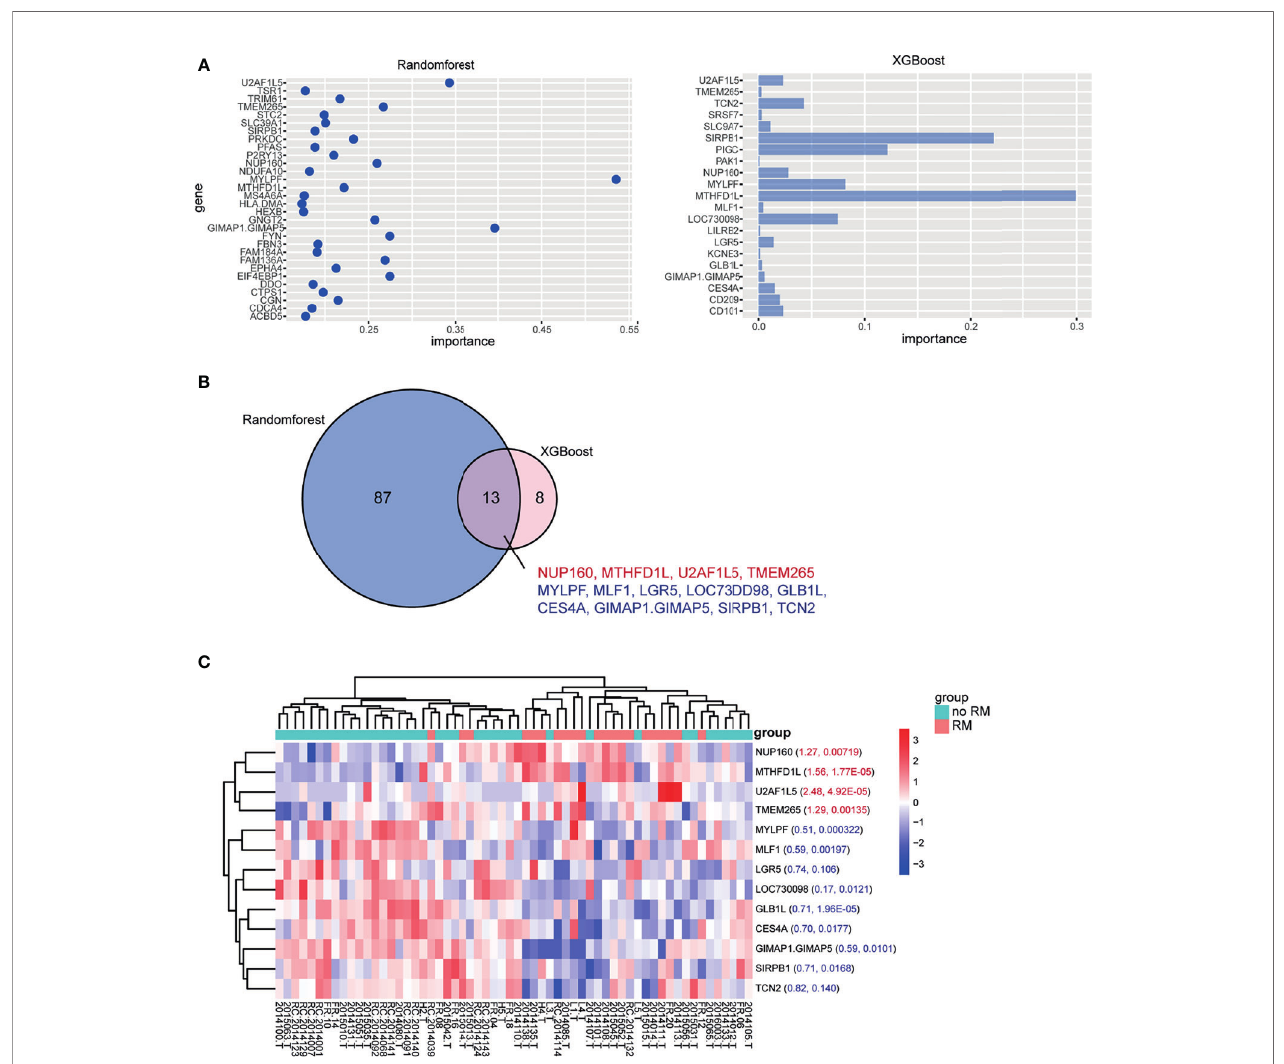
FIGURE 1 | Signi fi cant genes in the RM and no-RM groups. (A) mRNAs identi fi ed in the RM and no-RM groups classi fi ed based on the mRNA expression dataset with the RF method (left) and XGBoost method (right). (B) Thirteen mRNAs overlapped between the two methods. Red font indicates high expression in the RM group, and blue font indicates low expression in the RM group. (C) Heatmap of the expression of the 13 signi fi cant genes between the no-RM and RM groups. The foldchange and p value were marked respectively in the